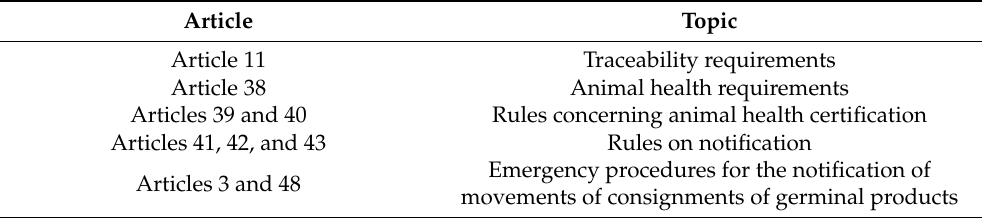
Table 1. Articles of Regulation (EU) 2020/686 relating to movements of germinal products of camelids to other member